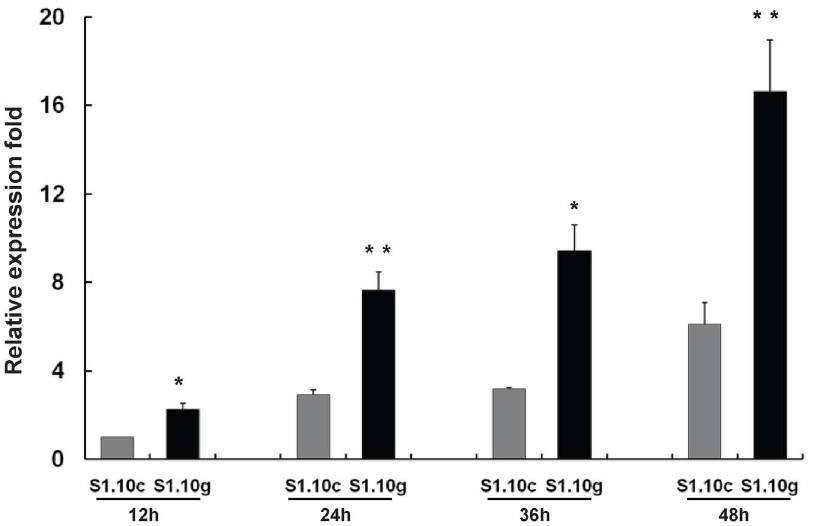
Figure 3. Expression profiles of S1.10-cDNA and S1.10-gDNA. The mRNAs were sampled at 12, 24, 36 and 48 h after cell transfection. The data are expressed as the mean values 6 SD (n=3). *, p , 0.05; **, p , 0.01 .